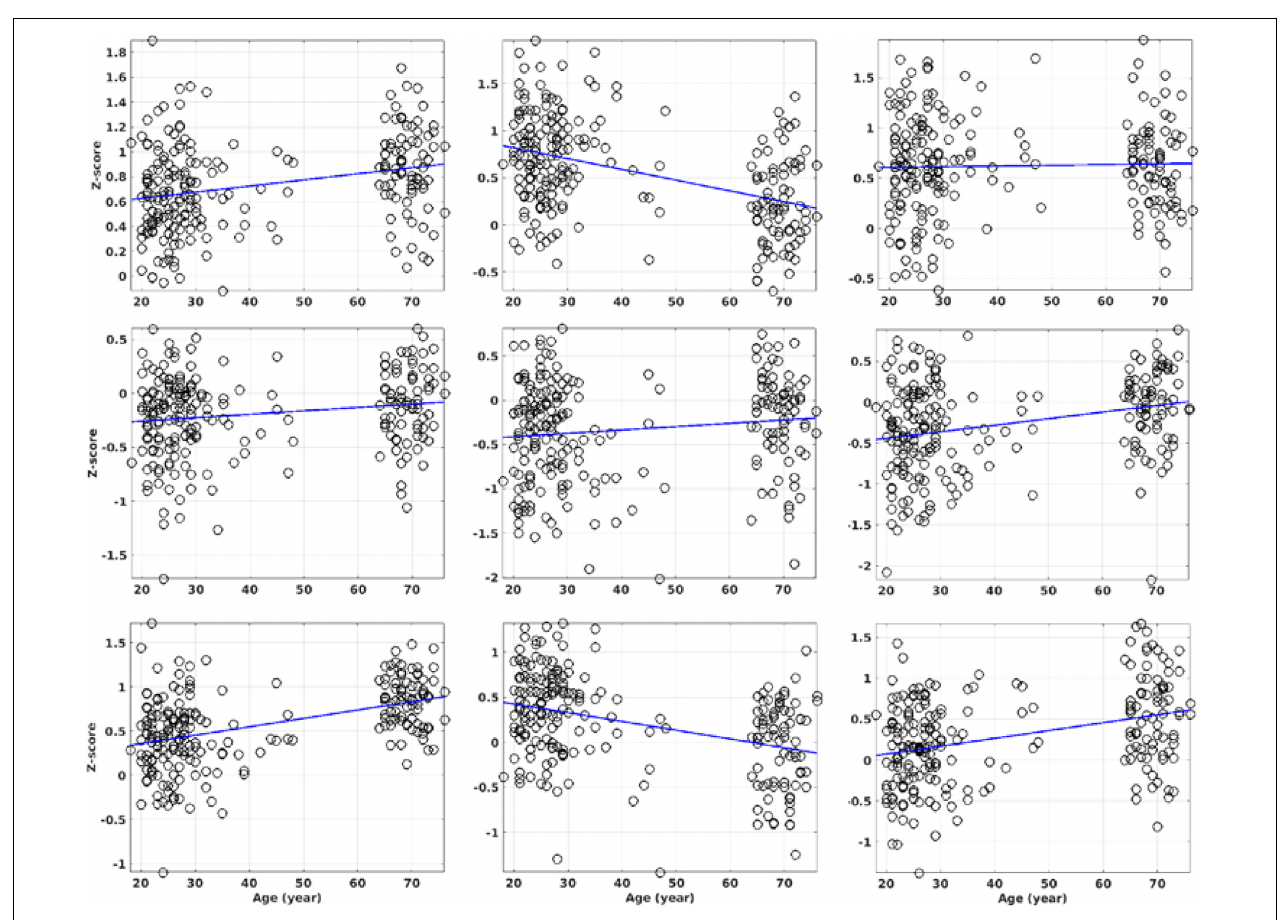
FIGURE 11 | The ROI average of the CSI P , CSI N , and CSI metrics against the subject’s age for the 3 ROIs with significant correlation between CSI and the subject’s age. The details of the regression results are summarized in Table 4 . The columns 1 to 3 are the results for the ROIs in the precuneus, MFG, and R-IPL, respectively. The rows 1 to 3 are the results for the CSI P , CSI N and CSI metrics, respectively. The ROI masks are solely based on the CSI metric